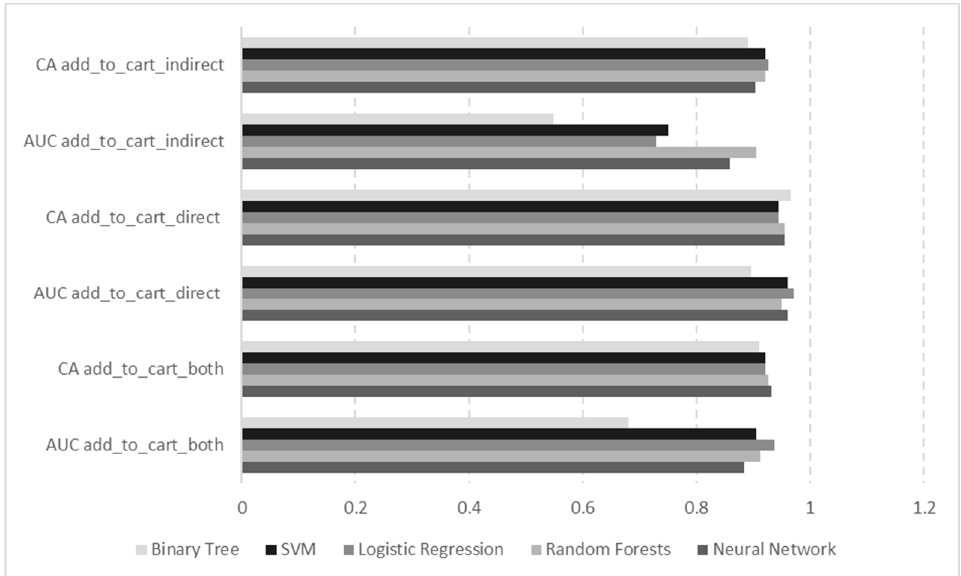
Figure 7. Classification accuracy metrics for all target variables received for different models.